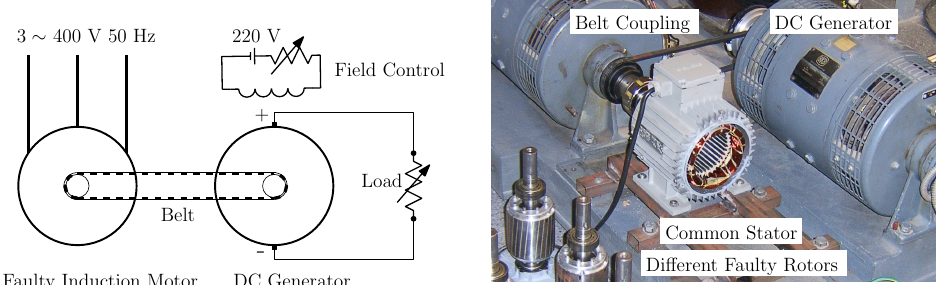
Figure 12. Schema of the loading of the experimental machine ( left ) and experimental setup ( right ). The induction motor under test (Appendix A) is connected to a DC generator via a belt coupling. The DC machine feeds a resistive load. Both the resistive load and the field excitation can be controlled so that the induction machine works at rated